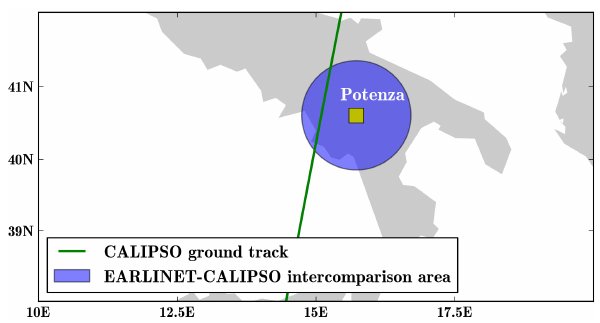
Figure 1. Example showing CALIPSO’s ground track that passes the EARLINET measurement site at Potenza at a distance of less than